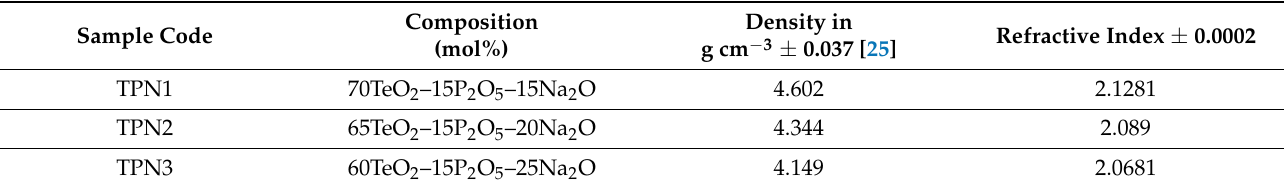
Table 1. The composition, density ( ρ ), and refractive index (n) of TPN glass system.